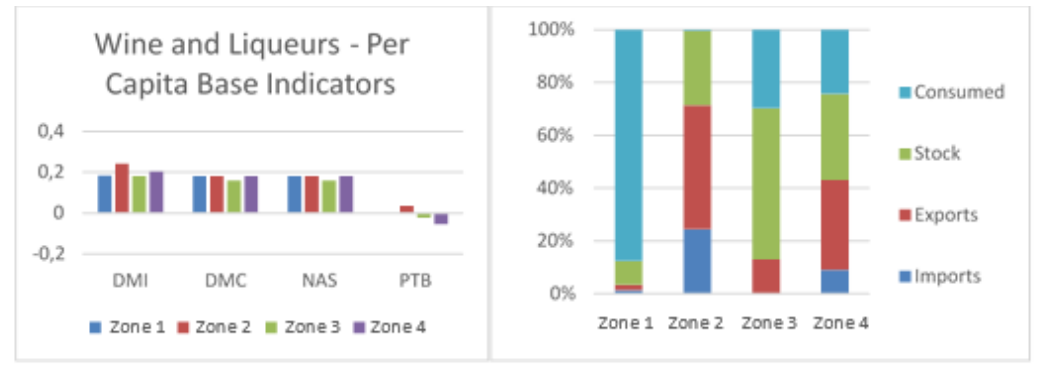
Figure 3. Examples of graphic representations produced by REMET-UA model [23].